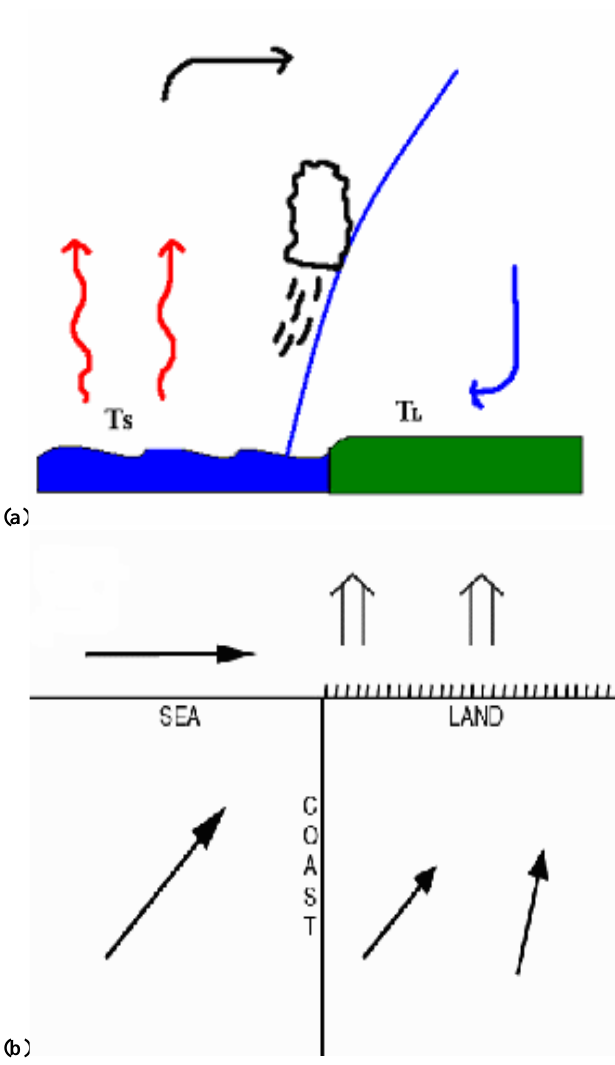
Fig. 1. Sketch of the physical processes responsible of the forma- tion of coastal fronts: (a) thermal difference and (b) frictional con-